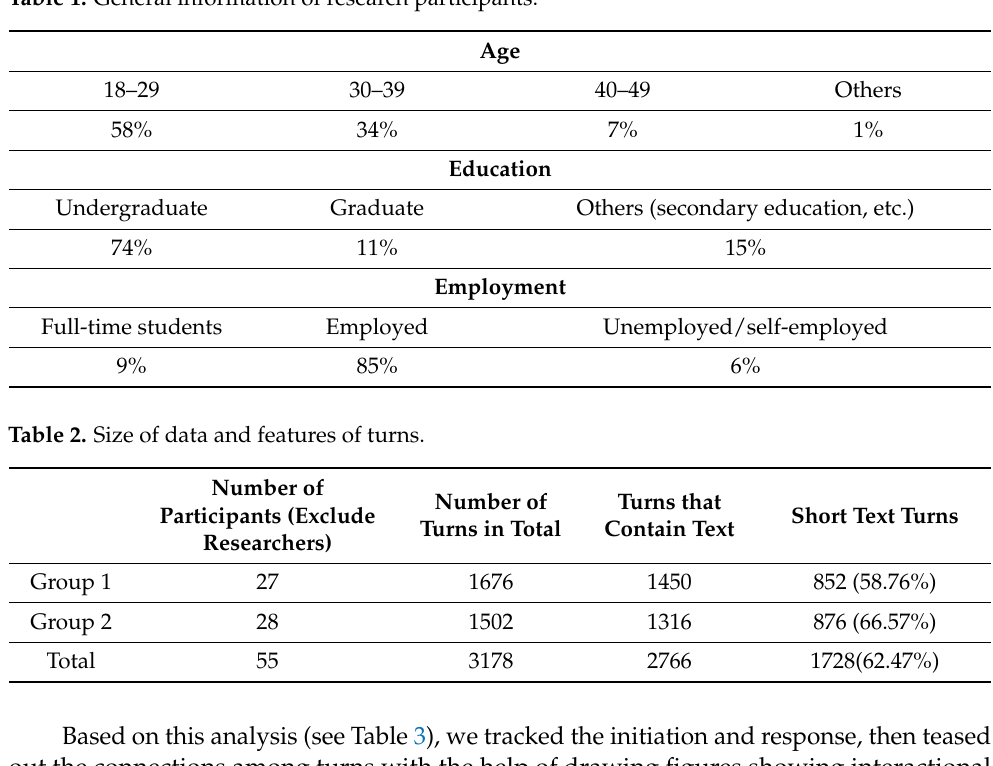
Table 1. General information of research participants.